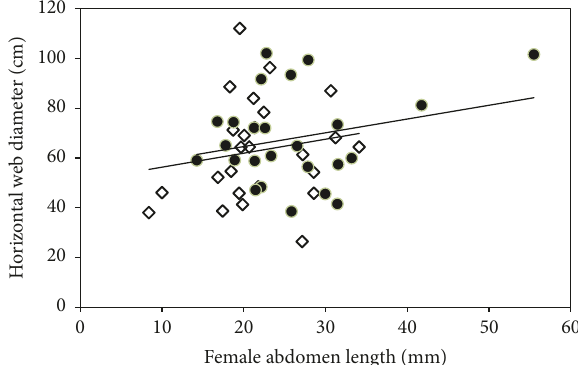
Figure 2: Relationship between abdomen size and web diameter in forest (solid circles) and nonforest (open diamonds) habitats in the wet zone of Sri